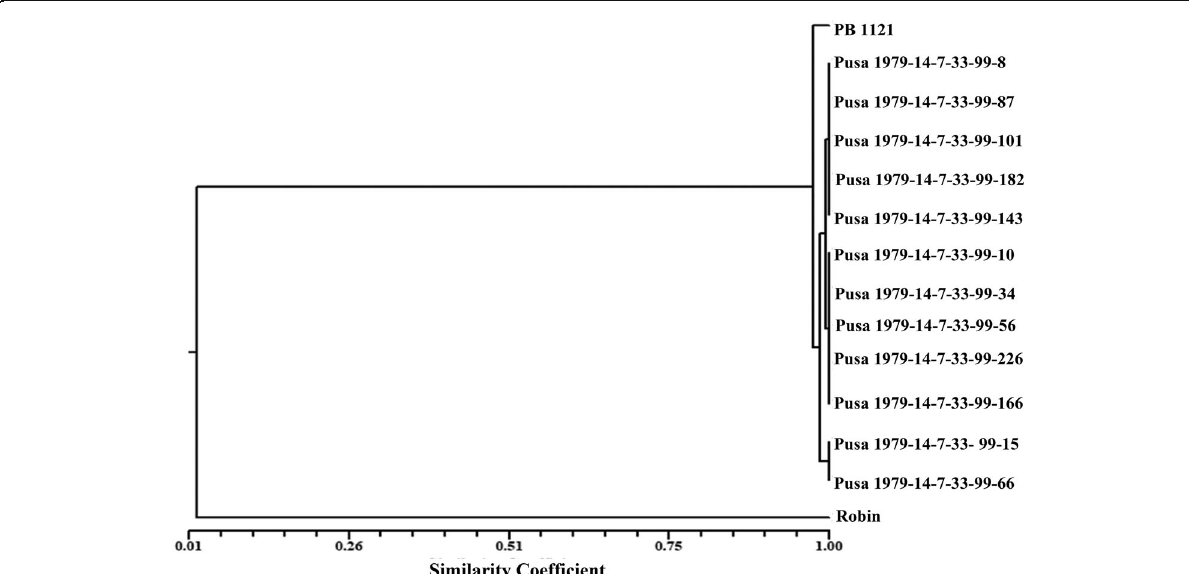
Fig. 4 Dendrogram showing the genetic relationship among different PB 1121 HT-NILs in BC 4 F 4 generation and their parents, PB 1121 and Robin based on 112 polymorphic SSR